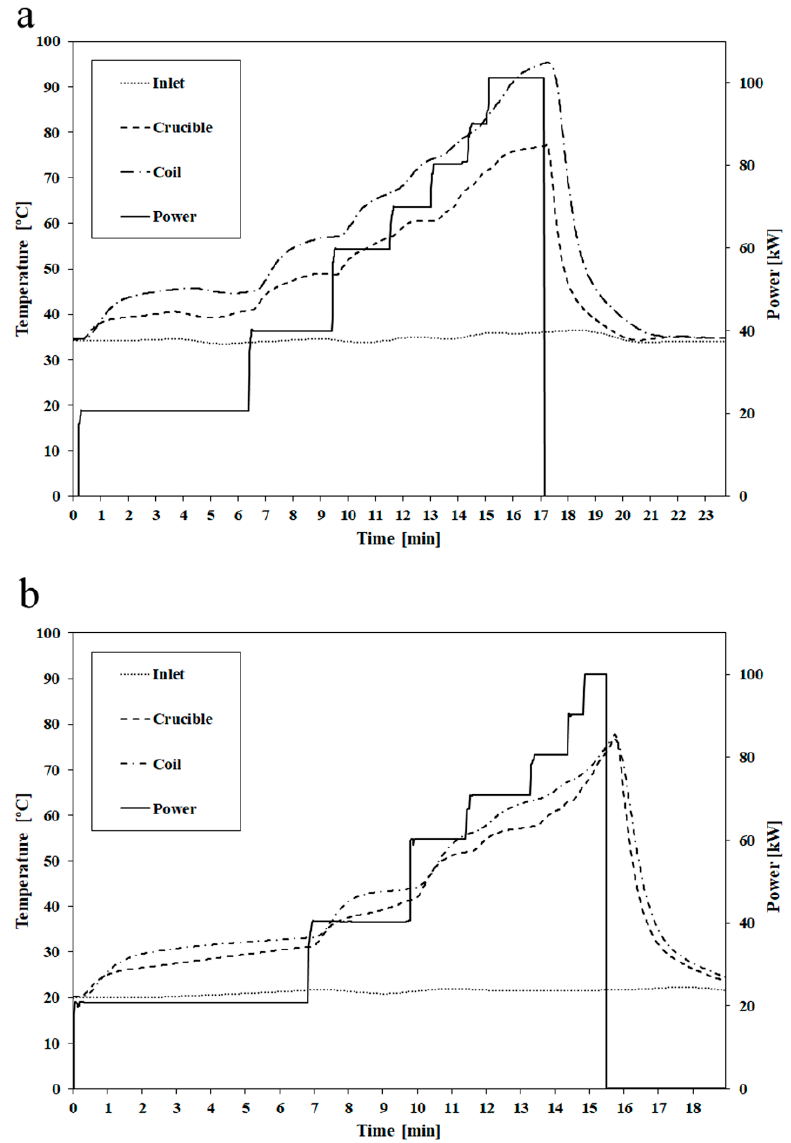
Figure 3. Cooling systems temperature evolution: ( a ) First melt. ( b ) Second melt.